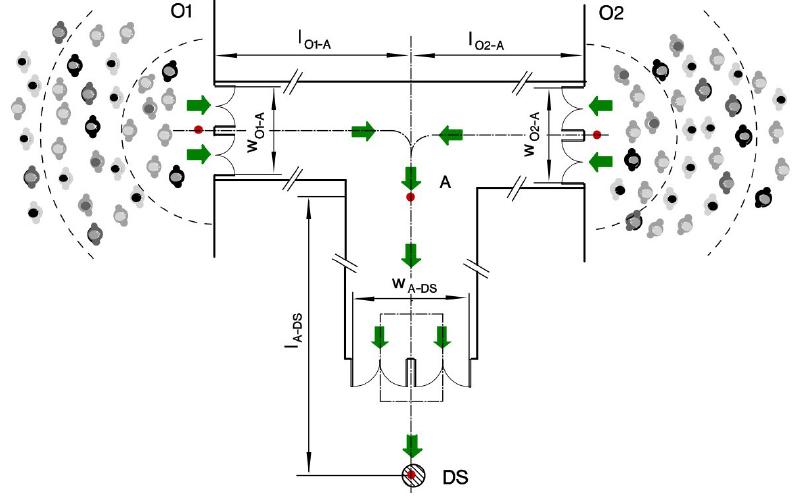
Figure 16. Example of a